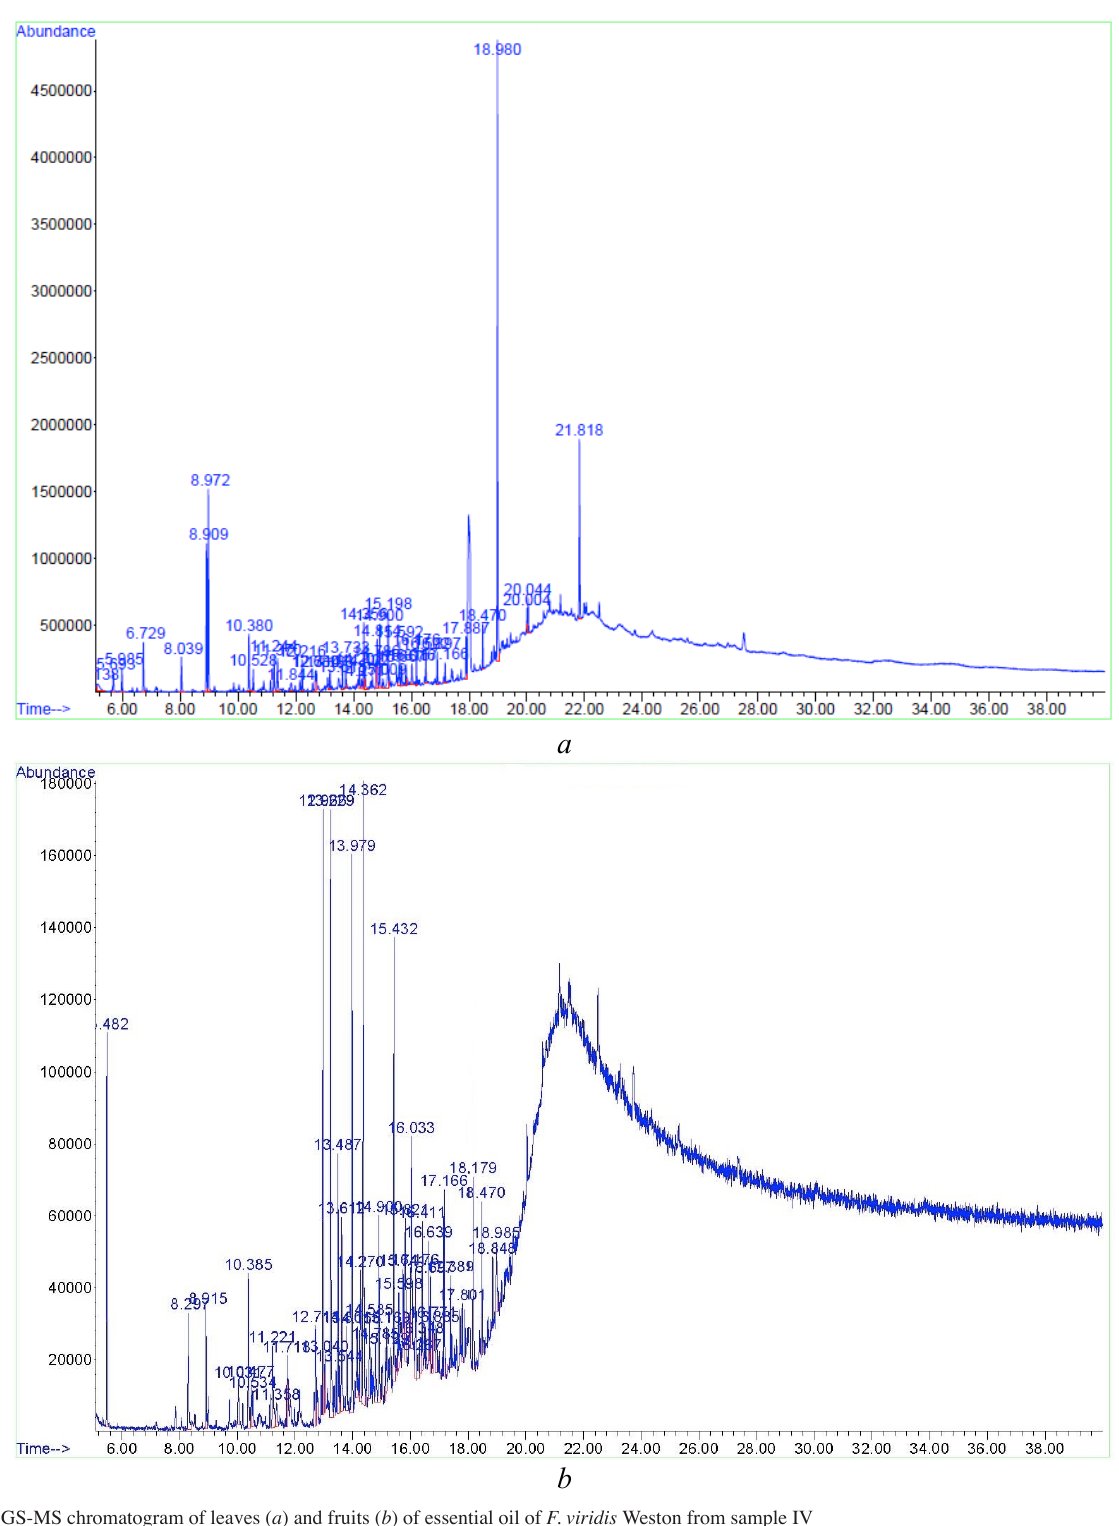
Fig. S4: GS-MS chromatogram of leaves ( a ) and fruits ( b ) of essential oil of F. viridis Weston from